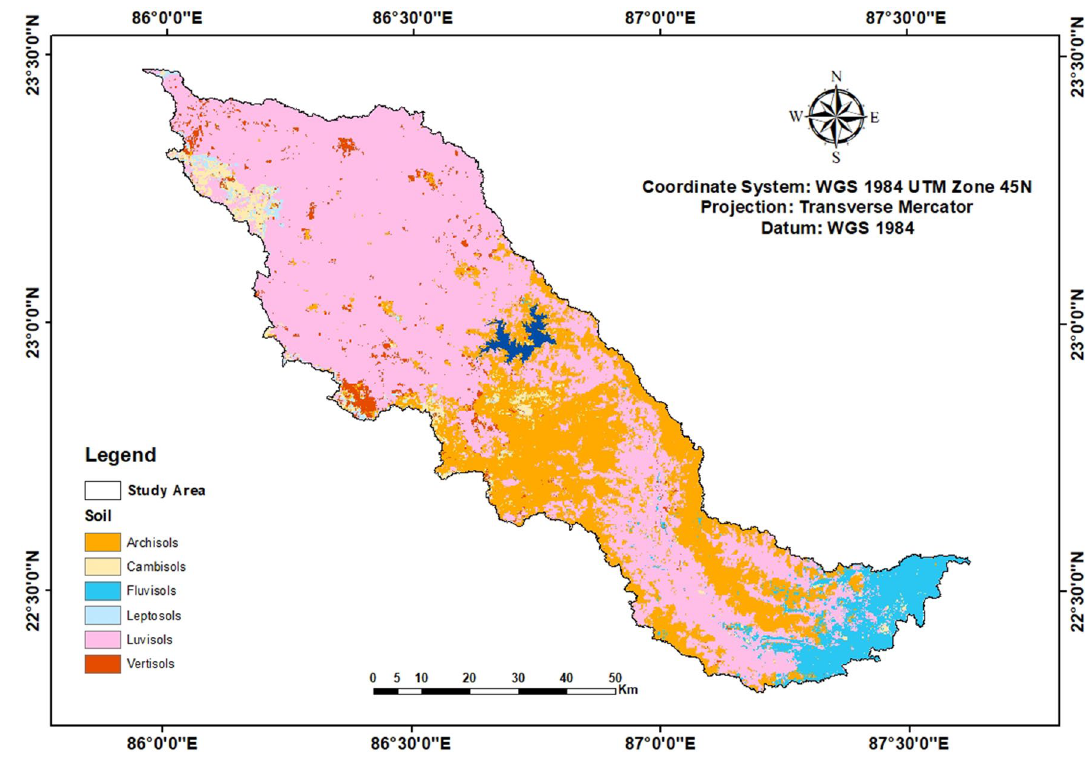
Fig. 11 Soil map showing spatial distribution of different soil orders in Kangsabati River basin